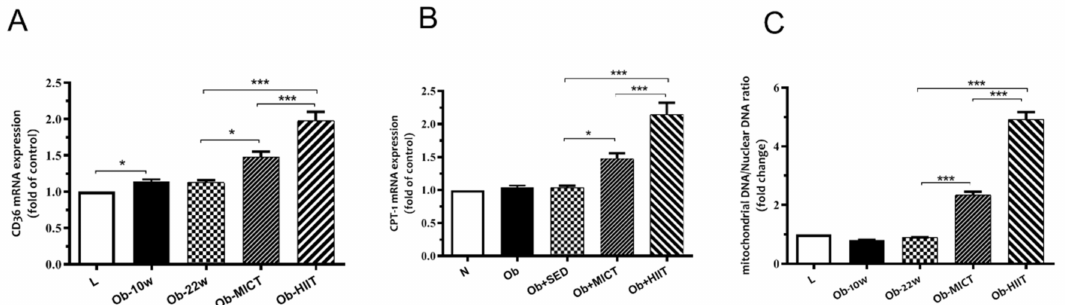
Figure 6. The e ff ect of obesity and exercise training on mRNA expression of ( A ) CD36, ( B ) carnitine palmitoyltransferase I (CPT1), and ( C ) mitochondrial DNA content (mtDNA) in subcutaneous adipose tissue. Data are represented as means ± SEM and significant di ff erence between groups indicated by * p < 0.05, *** p < 0.001. L: lean; Ob-10w: obesity-10 weeks; Ob-22w: obesity + sedentary; Ob-MICT: obesity + moderate-intensity continuous training; Ob-HIIT: obesity + high-intensity interval training